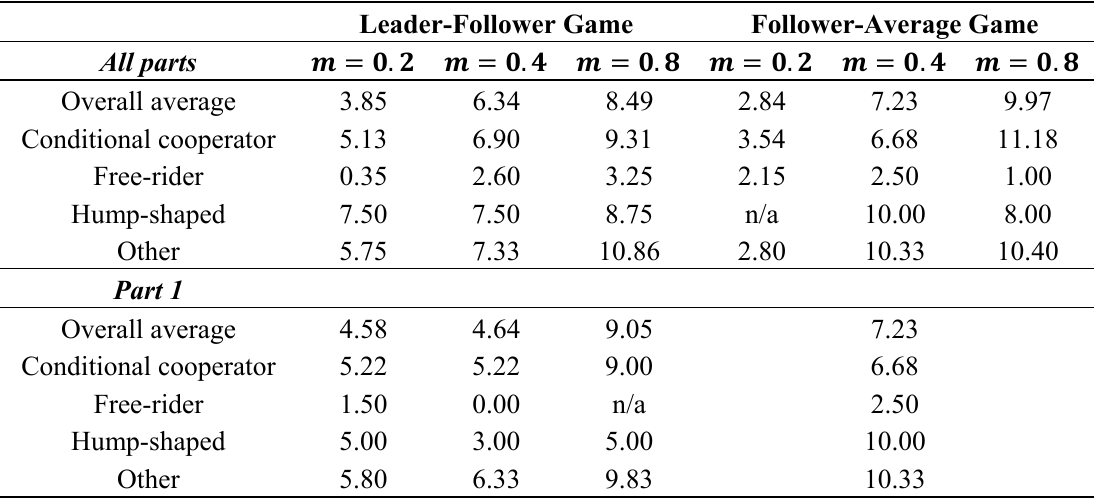
Table 6. Average unconditional contribution overall and by type for the six different games.